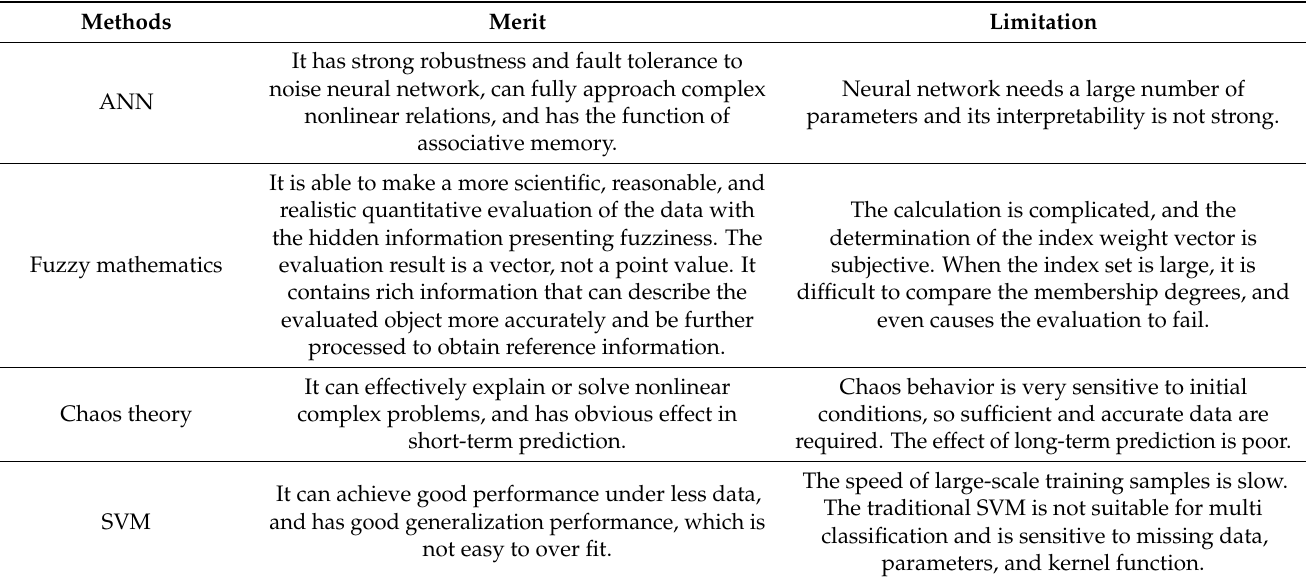
Table 4. Merits and limitations of various methods.